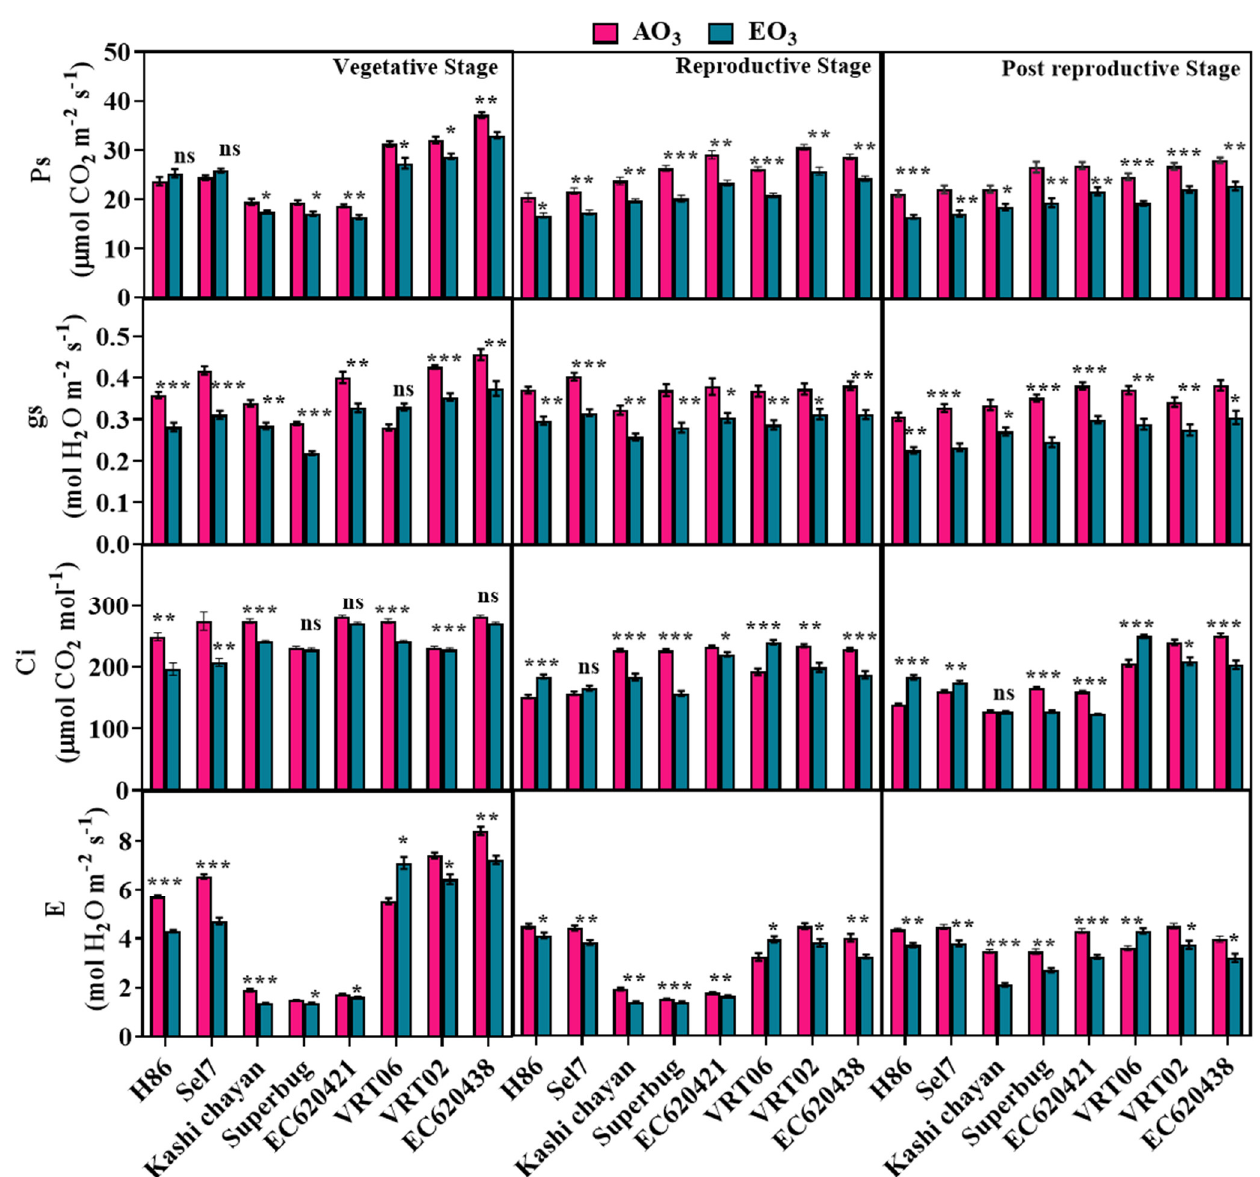
Figure 6. Variations in physiological characteristics (photosynthetic rate, stomatal conductance, internal CO 2 and transpiration) of tomato cultivars under ambient O 3 and elevated O 3 treatments at different growth stages. Values are mean ± SE. Levels of significance between AO 3 and EO 3 based on t -test: * p ≤ 0.05; ** p ≤ 0.01; *** p ≤ 0.001; ns not significant.